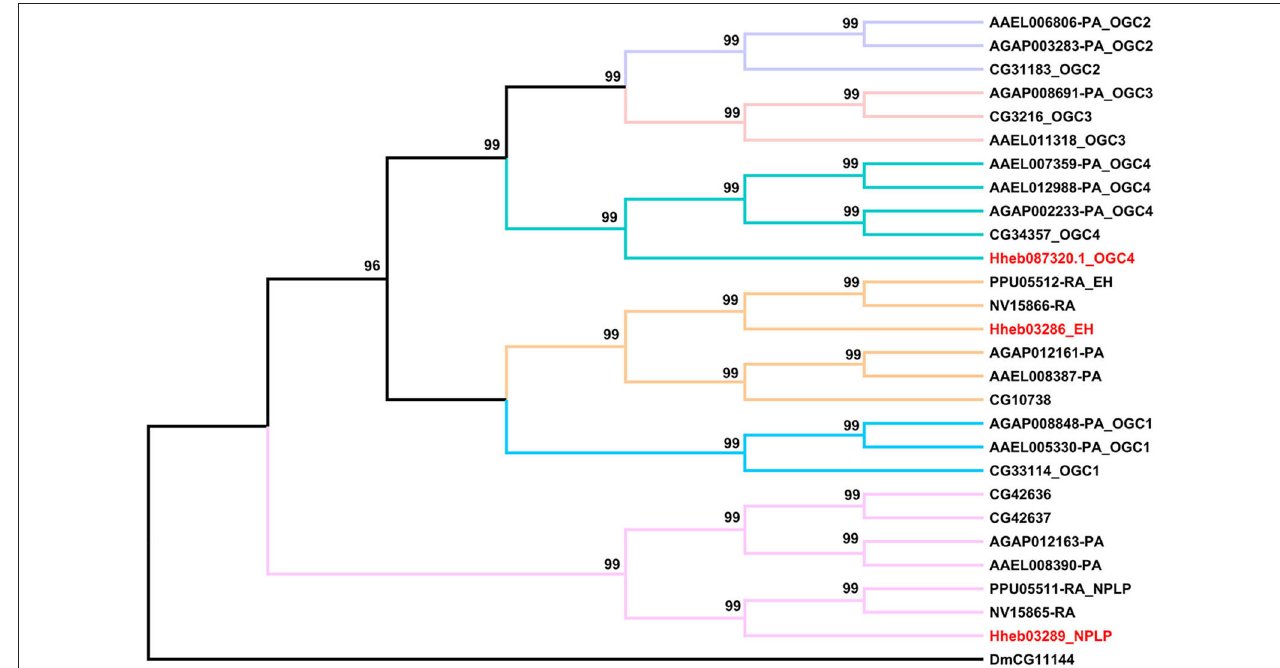
FIGURE 7 | Phylogenetic tree analysis of RGCs (receptor guanylyl cyclase) from H. hebetor (Hh), A. aegypti (AAEL), A. gambiae (AGAP), D. melanogaster (Dm), P. puparum (Pp), and N. vitripennis (Nv). The numbers at the nodes of branches indicate the posterior probability for each branch. The red labels are from H. hebetor . The amino acid sequences used are listed in the Supplementary Material File 6 .